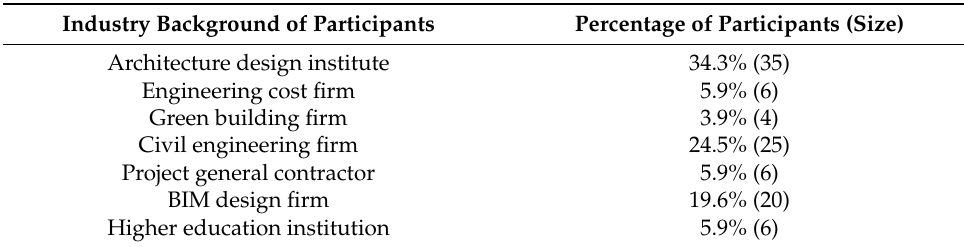
Table 1. Survey participants’ backgrounds involved.